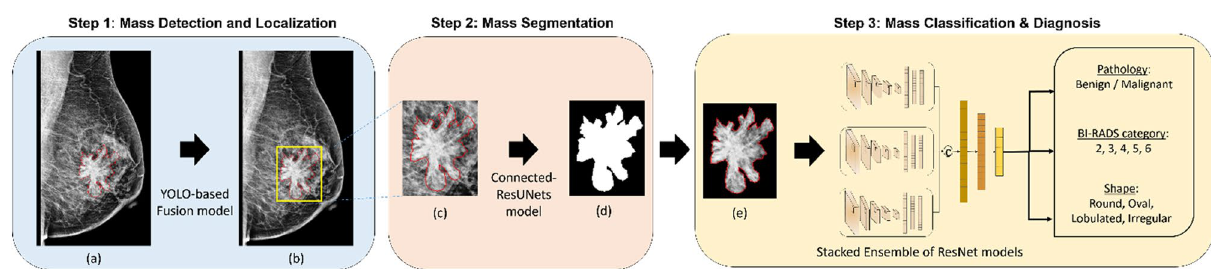
Figure 3. The proposed integrated CAD framework. ( a ) Original mammogram with ground truth of mass (red), ( b ) Detected ROI of mass (yellow) superimposed on the original mammogram, ( c ) Detected ROI mass obtained with ground truth (red), ( d ) Output segmented binary mask of ROI mass, and ( e ) Segmented ROI mass with marked